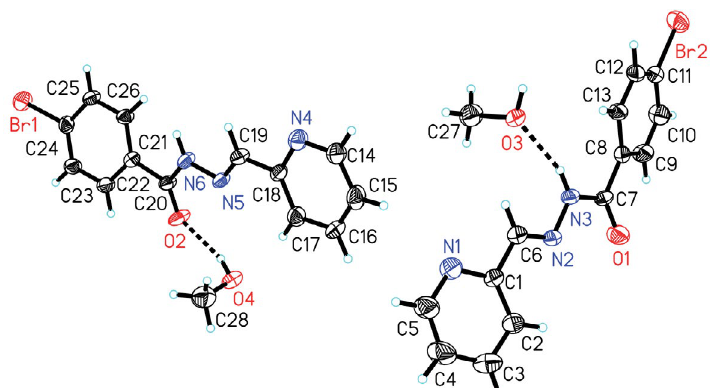
Figure 1. Molecular structure of HL, showing the atom-numbering scheme. Displacement ellipsoids for non-hydrogen atoms are drawn at 30% probability level.